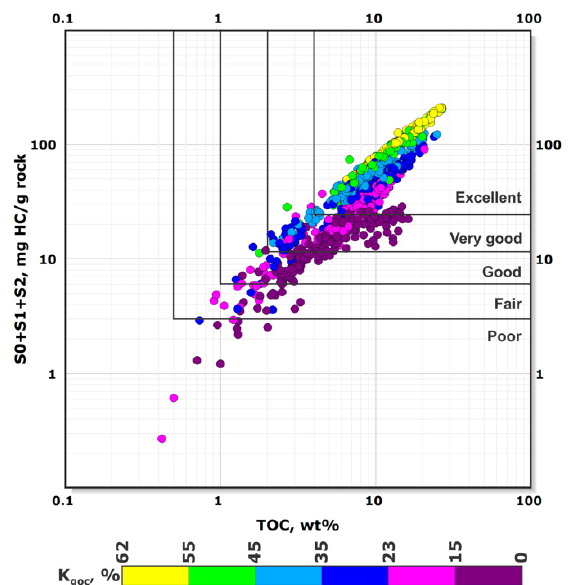
Figure 2. Characteristics of the generation potential of the Bazhenov Formation deposits. The color indicates the proportion of generative kerogen K goc = (GOC ex /TOC ex ) × 100, %.